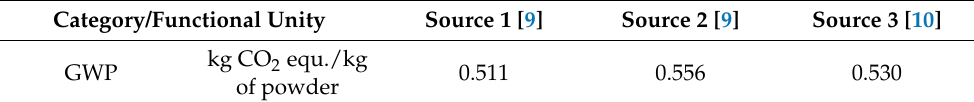
Table 2. Impact evaluation for C2S tile adhesives according to different sources (modules A1–A3).